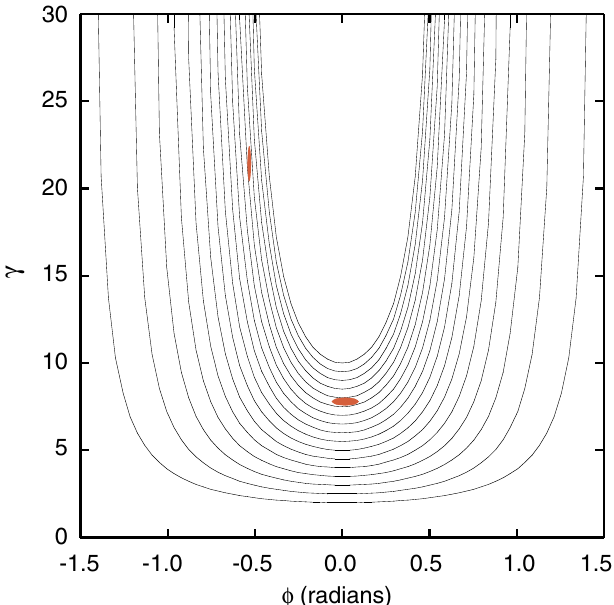
FIG. 18. (Color) Longitudinal phase space particle trajectories in a traveling wave linac section modeled by a sinusoidal accelerating field. The rf parameters used in the plot are typical values for the LLNL 100 MeV linac. The plot illustrates the phase space rotation compression mechanism for a bunch in- jected near the rf zero